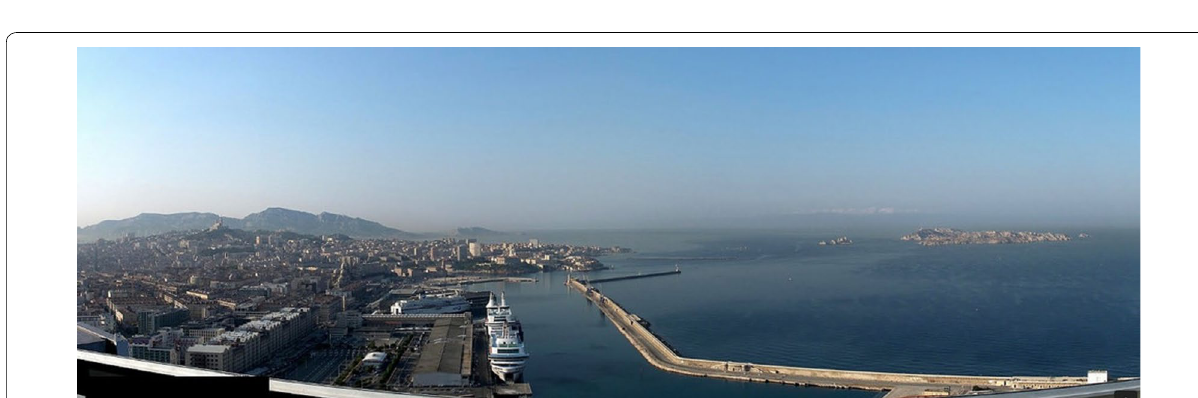
Fig. 9 Requalification of a neighborhood in Marseille (FR) through ocean thermal energy (http://www.pss-archi .eu)